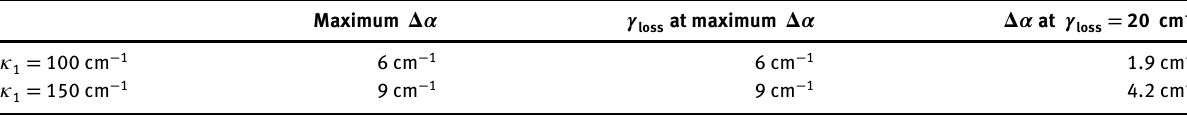
Table 1: Values of Δ 𝛼 and their corresponding 𝛾 loss for two representative coupling strength 𝜅 1